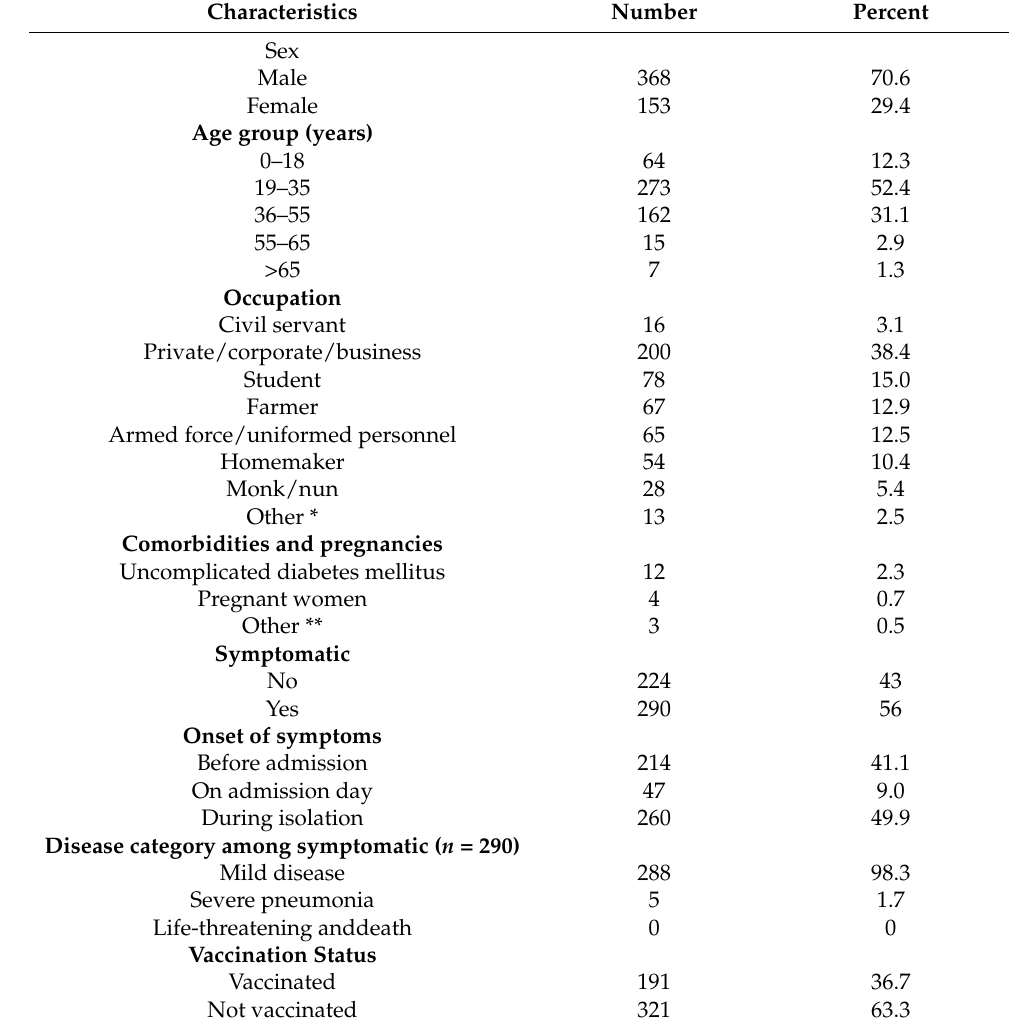
Table 1. Characteristics of COVID-19 patients admitted to Phuentsholing isolation ward,